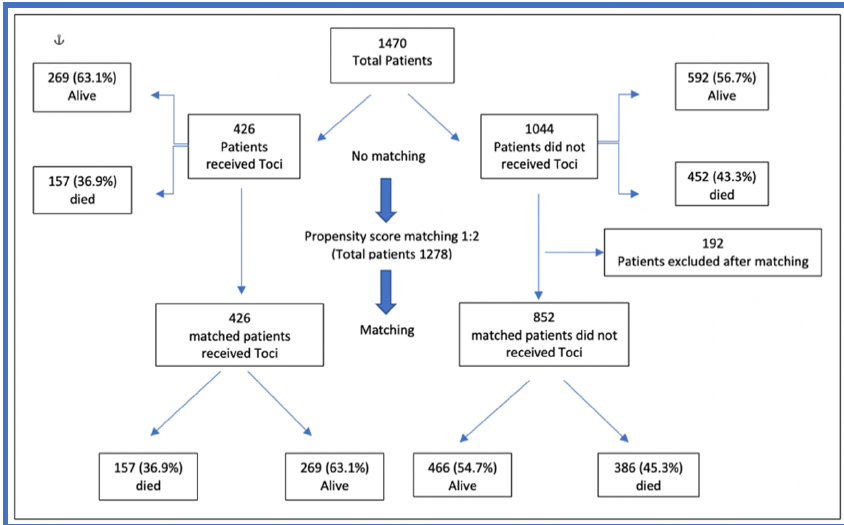
Figure 1. The flowchart of patients’ recruitment and propensity-matching.